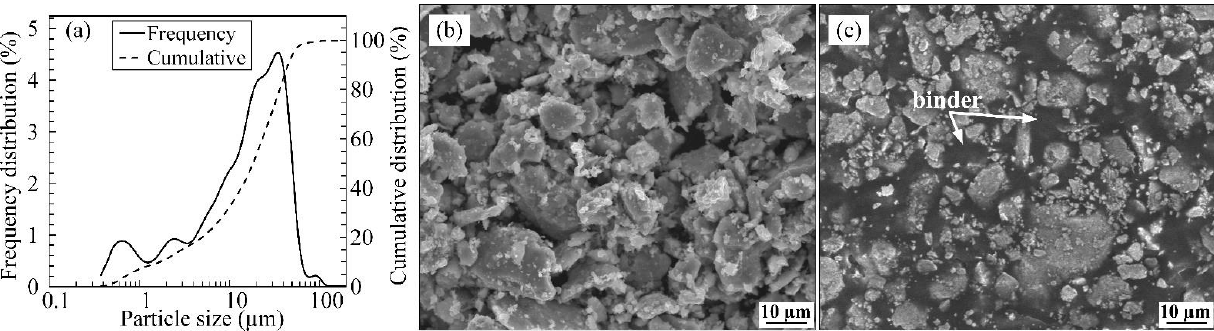
Figure 1a. The irregular morphology of the powder-binder mixture's dry powder and ho- mogeneity were observed using a Hitachi 3600 scanning electron microscope (SEM)( Hi- tachi, Tokyo, Japan), as illustrated in Figure 1b,c. The feedstock was prepared by blending 55 vol. % of iron powder with a multi-component binder system containing 42 vol. % of iron powder with a multi-component binder system containing 42 vol.% of paraffin wax paraffin wax (PW) used as the main carrier, 2 vol. % of stearic acid (SA) promoting the (PW) used as the main carrier, 2 vol.% of stearic acid (SA) promoting the surfactant effect, surfactant effect, and 1 vol. % of ethylene-vinyl acetate (EVA) used as a thickening agent and 1 vol.% of ethylene-vinyl acetate (EVA) used as a thickening agent to avoid the segre- to avoid the segregation phenomenon. These binder constituents were selected due to gation phenomenon. These binder constituents were selected due to their extensive use in their extensive use in LPIM [33,34]. The solid loading reached in this study represents a LPIM [33,34]. The solid loading reached in this study represents a typical value for irregular typical value for irregular powders used in LPIM that are mainly reported for ceramic- powders used in LPIM that are mainly reported for ceramic-based feedstocks [35,36]. based feedstocks [35,36].